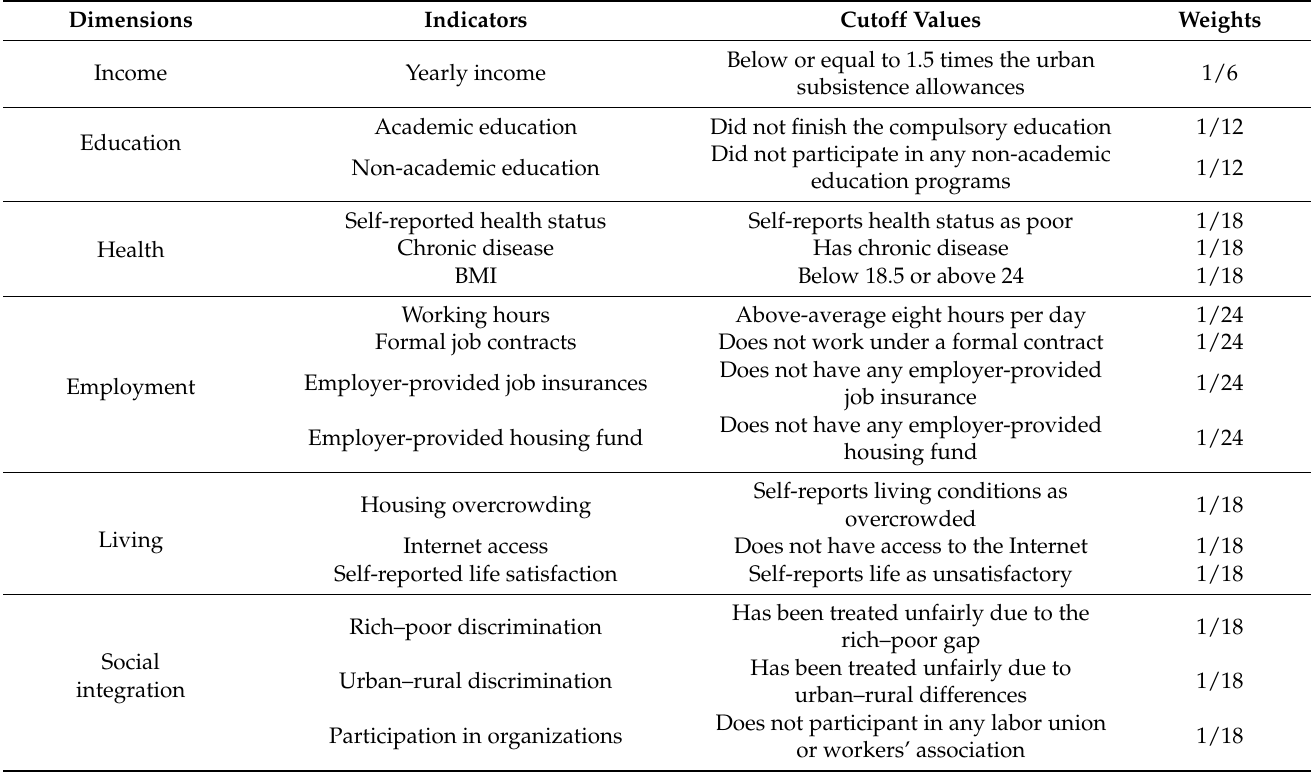
Table 1. Measurement of migrant workers’ relative poverty: dimensions, indicators, cutoff values, and